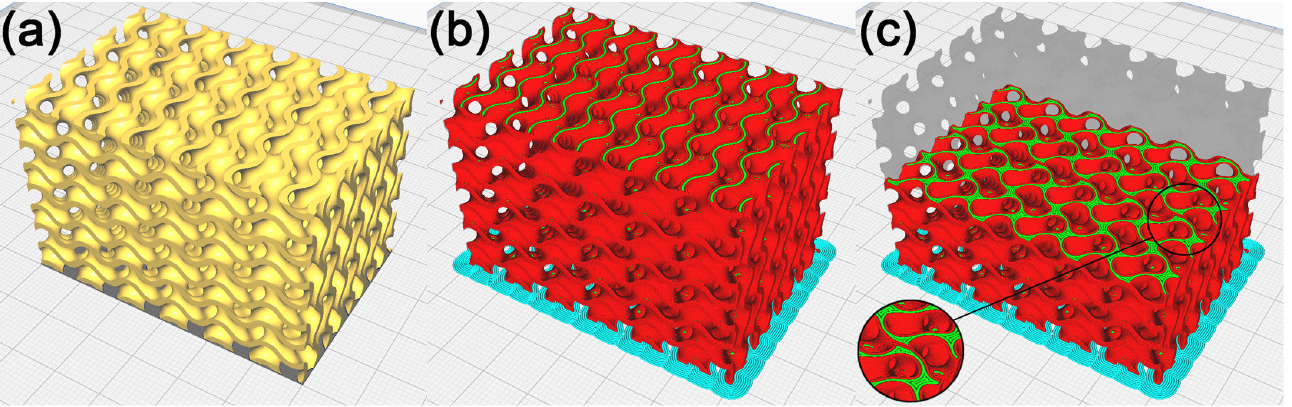
Figure 6. Cellular structure model with duplicated surfaces inside the model. ( a ) Model placed in Cura, ( b ) illustration of the toolpath process in production by FDM technology, and ( c ) illustration of the toolpath in the model’s inner layer.